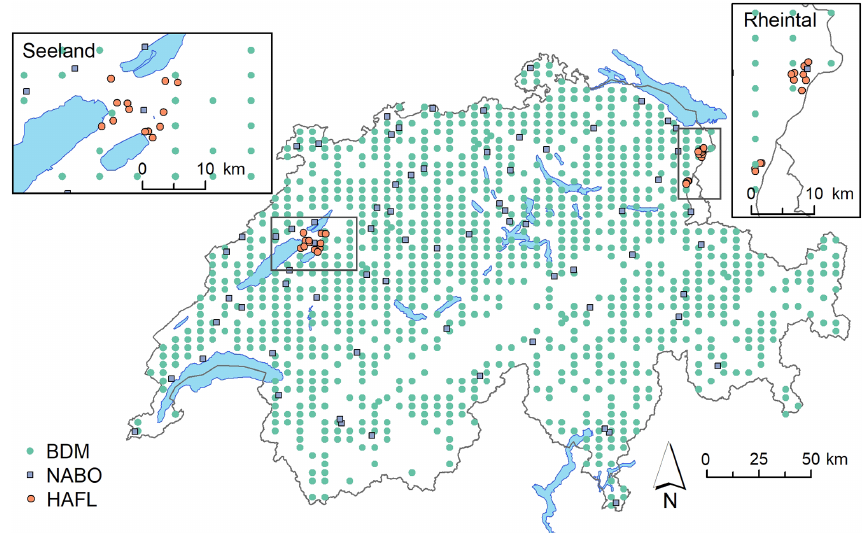
Figure 1. Spatial grid of BDM locations (green dots), NABO long-term monitoring locations (gray squares) and the purposive sampling design of peatlands in the Seeland and St. Galler Rheintal regions, which constitute the HAFL locations (orange dots; NABO, 2018; Gubler et al., 2015; FOEN, 2018; Meuli et al., 2017; Baumann et al., 2021). Table 1. Summary statistics of all samples in the HAFL data set, which is, in this study, also referred to as the local data set, and the BDM and NABO data sets. The latter two together constitute the current Swiss SSL, which contains carbon reference measurements from 4295 samples from 1150 different locations (Baumann et al., 2021). Q1 and Q3 refer to the first and third quartiles, respectively.